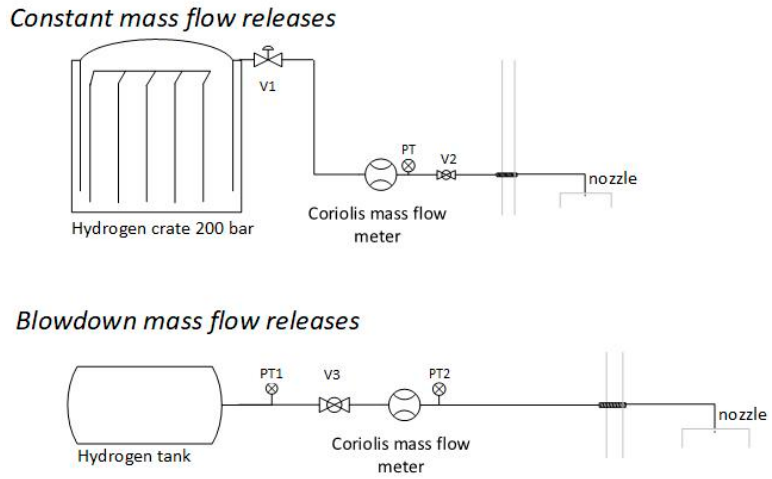
Figure 2. P and ID for hydrogen releases during experiments with constant and blowdown mass flow releases.